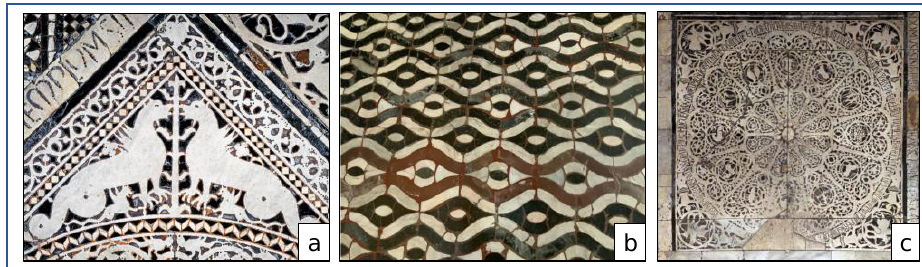
Figure 3. The pavement of the San Giovanni baptistery. ( a ) Detail showing fantastic animals facing one another (Archive of the Opera di Santa Maria del Fiore); ( b ) Detail of the three-colours geometric motif; ( c ) The zodiac showing in its centre the image of a flaming anthropomorphic Sun; the latter is surrounded by the signs of the constellations, inserted in a cosmic circle which in turn is inscribed in a